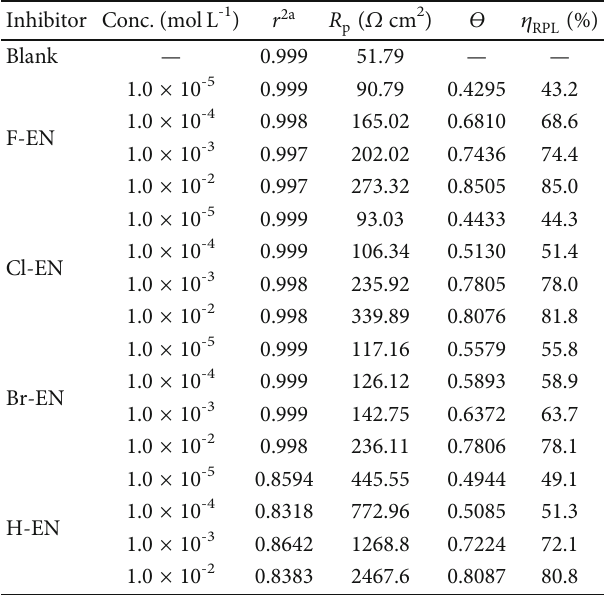
Table 3: Electrochemical parameters obtained from LPR tests for halogenated aniline β -enaminoesters in 1.0mol L -1 HCl medium in AISI 1020 carbon